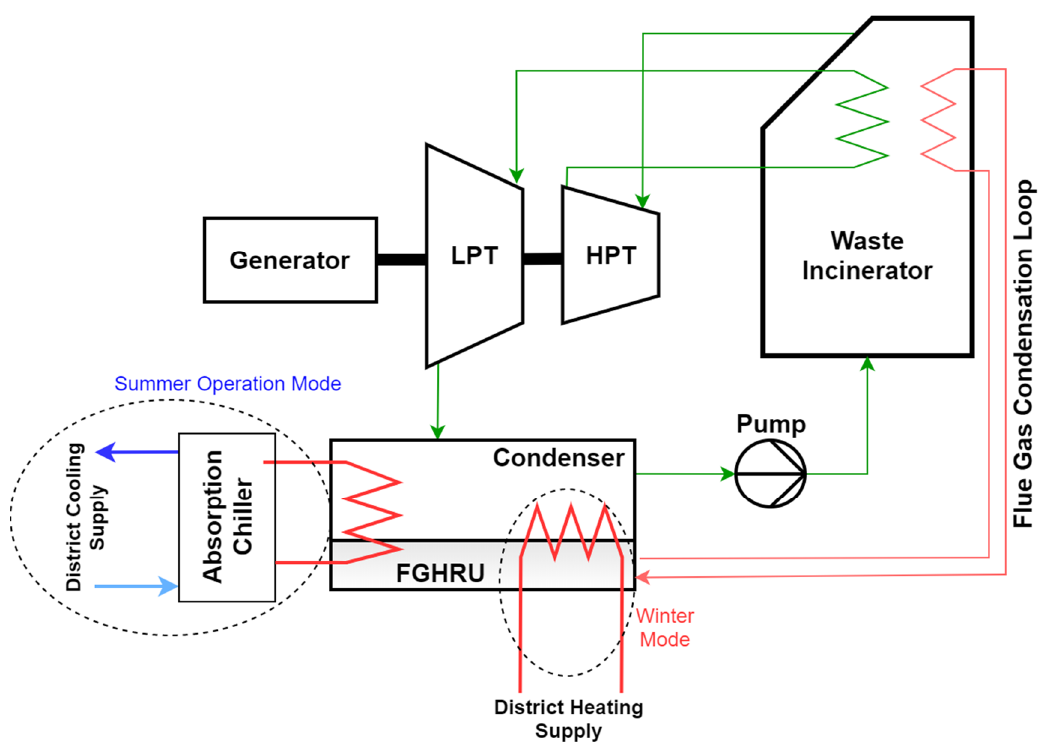
Figure 1. Schematic of the proposed solution; FGHRU: flue gas heat recovery unit; HPT: high- pressure turbine: LPT: low-pressure turbine.